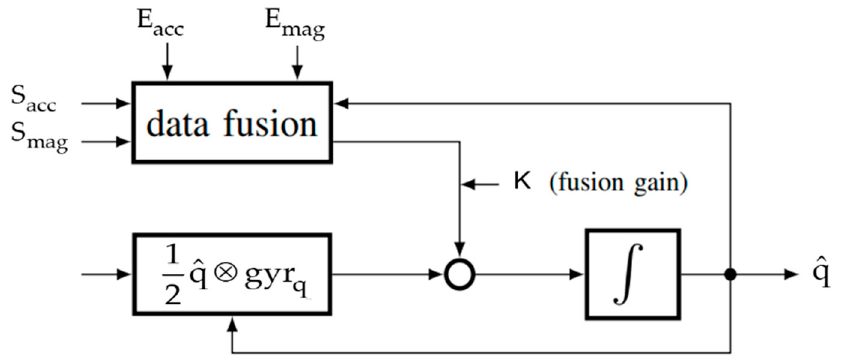
Figure 3. Attitude estimation architecture [39] © 2017 IEEE.